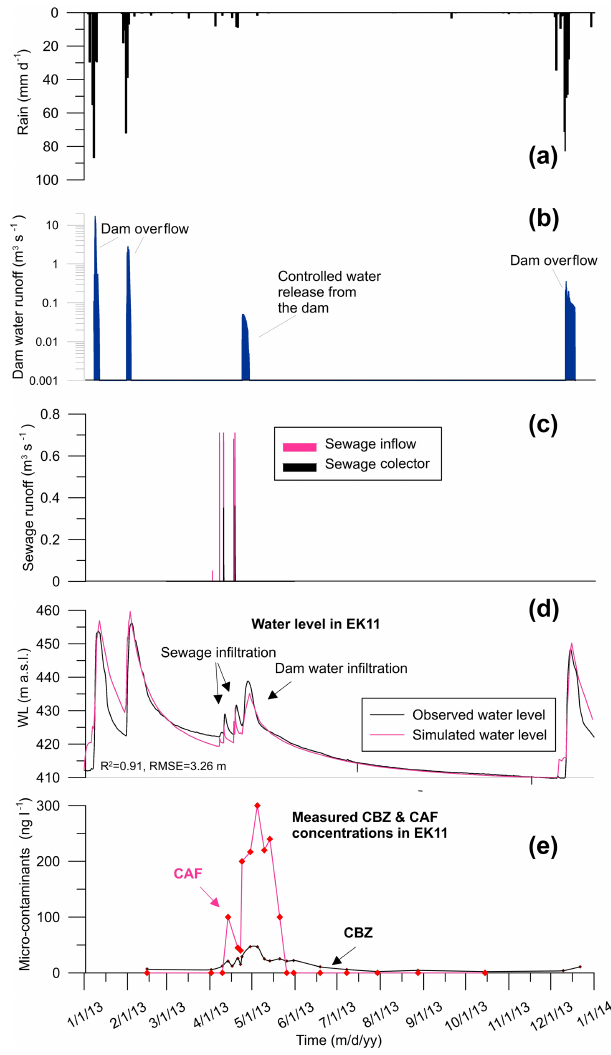
Figure 3. Time series data observation and calculation (following Dvory et al., 2018a). (a) Tzuba meteorological station daily precip- itation rate; (b) dam runoff flow; (c) sewage surface flow; (d) mea- sured and simulated aquifer water level at EK11. (e) measured CBZ and CAF